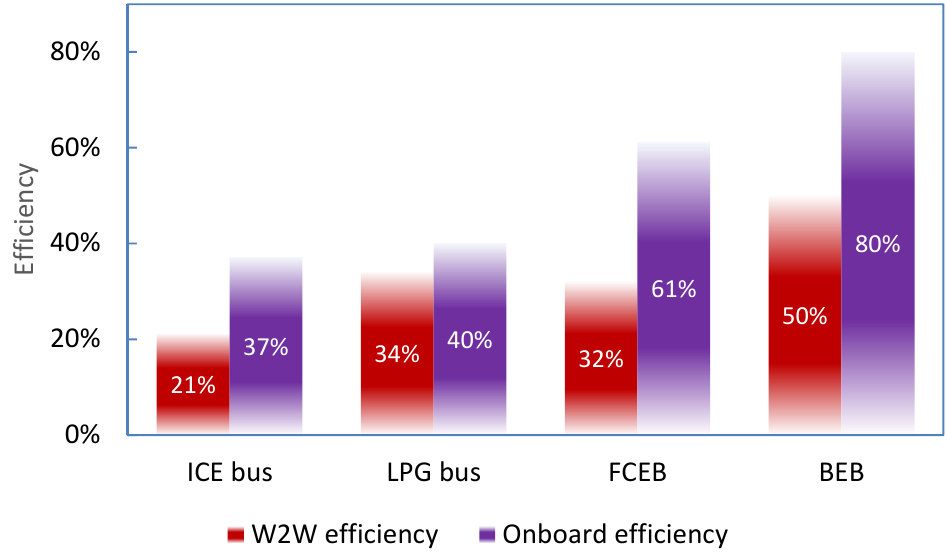
Figure 7. Efficiency estimates of the four types of buses.